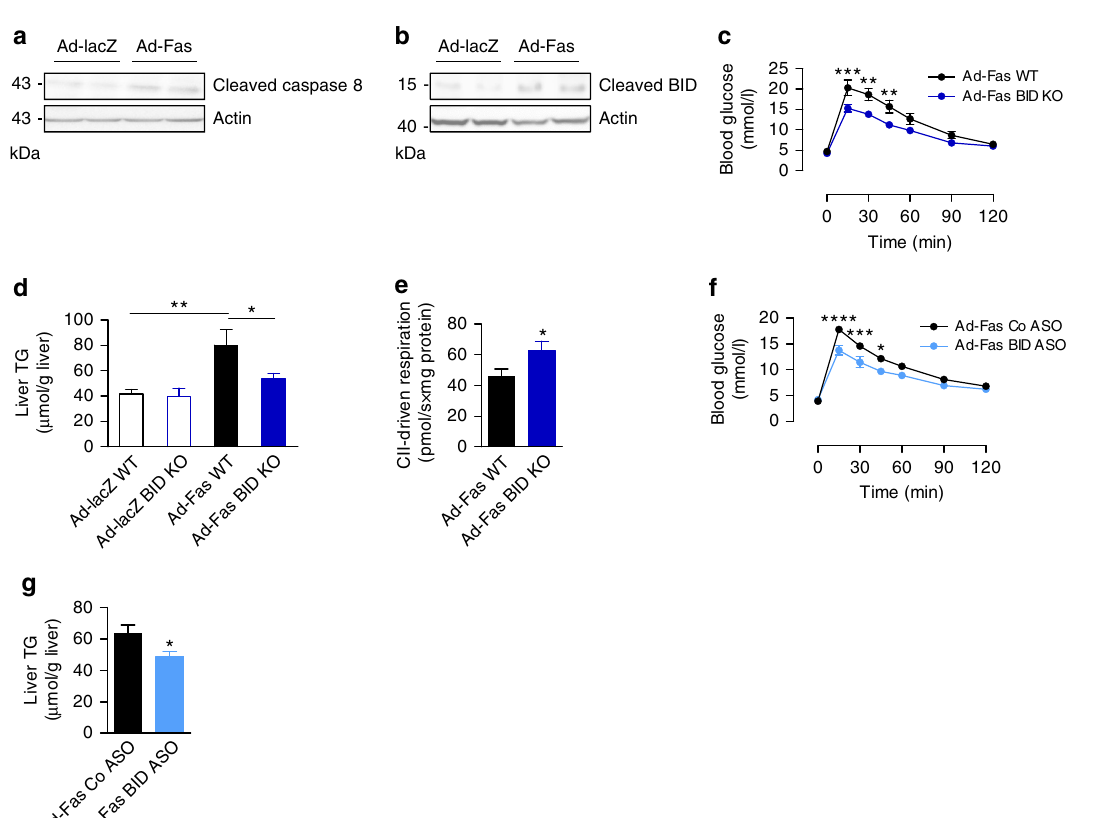
Fig. 4 Fas impairs mitochondrial function BID-dependently. Protein levels of a cleaved caspase 8 (p43) and b cleaved BID in total liver lysate harvested from mice 15 – 16 days after injection of Ad-lacZ or Ad-Fas. c Intraperitoneal glucose tolerance test (Ad-Fas WT, n = 4; Ad-Fas BID KO, n = 6), d liver TG levels (Ad-lacZ WT, n = 4; Ad-lacZ BID KO, n = 5; Ad-Fas WT, n = 4; Ad-Fas BID KO, n = 6) and e hepatic mitochondrial respiration in BID-knockout ( blue , n = 10) and WT ( black , n = 9) mice 12 days after injection of Ad-lacZ or Ad-Fas are depicted. f Intraperitoneal glucose-tolerance test ( n = 6) and g liver TG levels ( n = 4) in mice that received antisense oligonucleotides against BID (BID-ASO; light blue ) or control-ASO ( black ) 12 days after injection Ad-Fas are depicted. Values are expressed as mean ± s.e.m.; * p < 0.05, ** p < 0.01, and *** p < 0.001. Statistical tests used: t -test for ( e , g ) and ANOVA for ( c , d , f